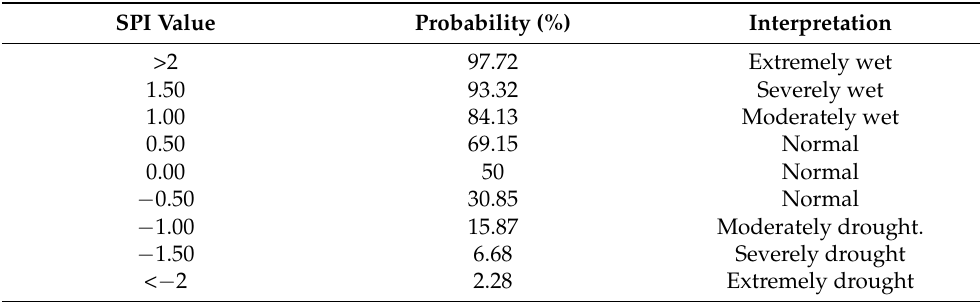
Table 1. SPI by categories and their probability of occurrence. Source: Edwards and McKee, 1997. SPI Value Probability